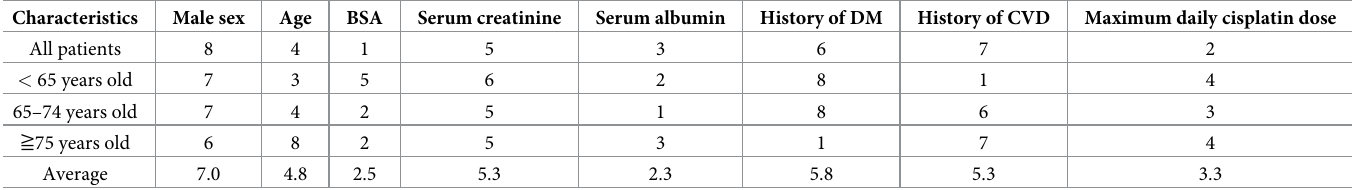
Table 3. Rank of contribution as a prediction factor of Cis-AKI. Characteristics